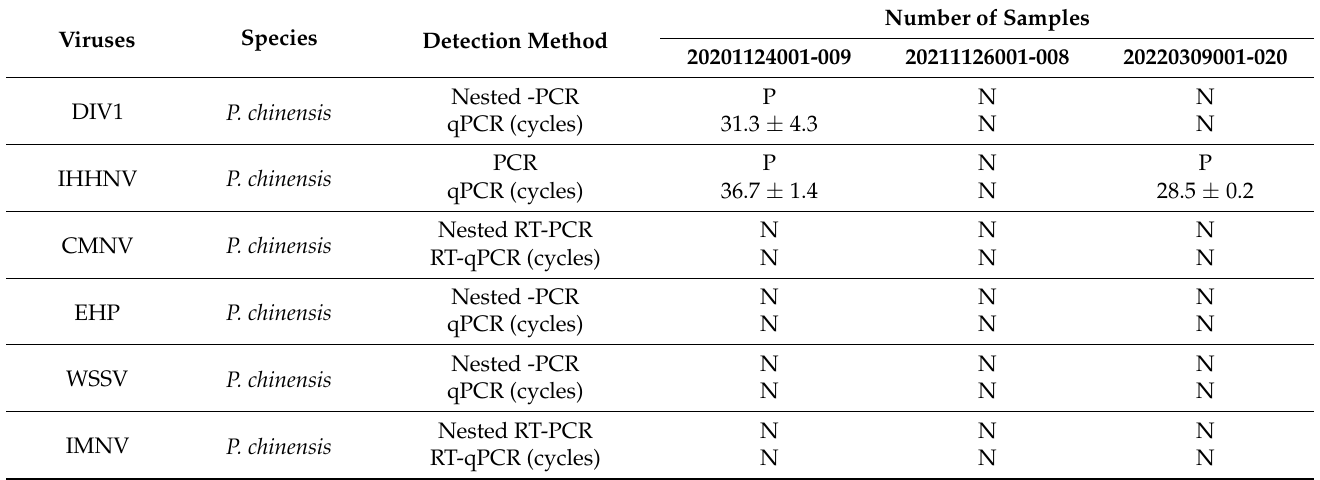
Table 2. Testing results for seven pathogens with the pooled